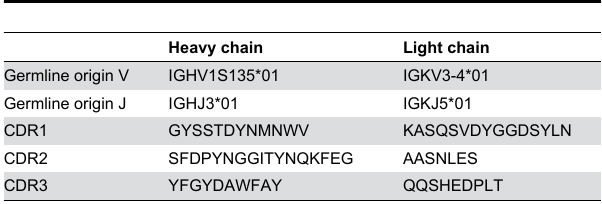
Table 1. Germline origin and CDRs of light and heavy chains of anti-tritrpticin mAb 6C6D7.